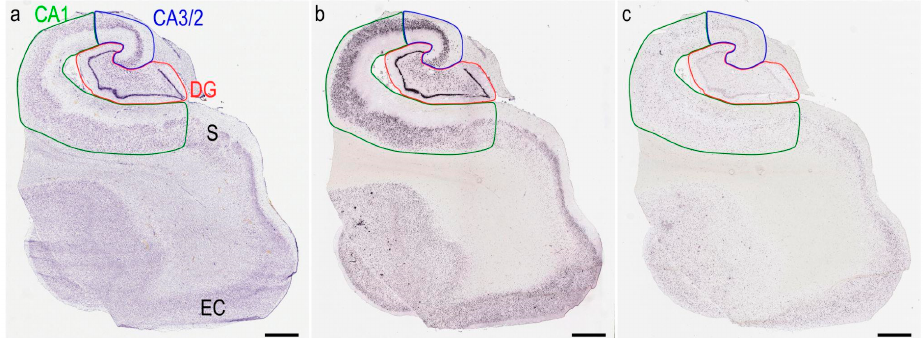
Figure 1. Images from hippocampal coronal sections processed through the Nissl method ( a ) and in situ hybridization for VGLUT1 ( b ) or GAT1 ( c ). This material was obtained from the donor H14.09.074. Nissl images were used as a template for the identification of hippocampal subfields. The dentate gyrus (DG, red), cornu ammonis 3/2 (CA3/2, blue) and 1 (CA1, green) were drawn for cell quantification. Identification of the subiculum (S) and entorhinal cortex (EC) was not possible for all samples. Images were obtained from the Aging, Dementia and TBI study database and are publicly available at: http://aging.brain-map.org/ (accessed on 14 October 2022). Anatomical charts were produced by the authors of the present work. Scale bars 2000 µm.